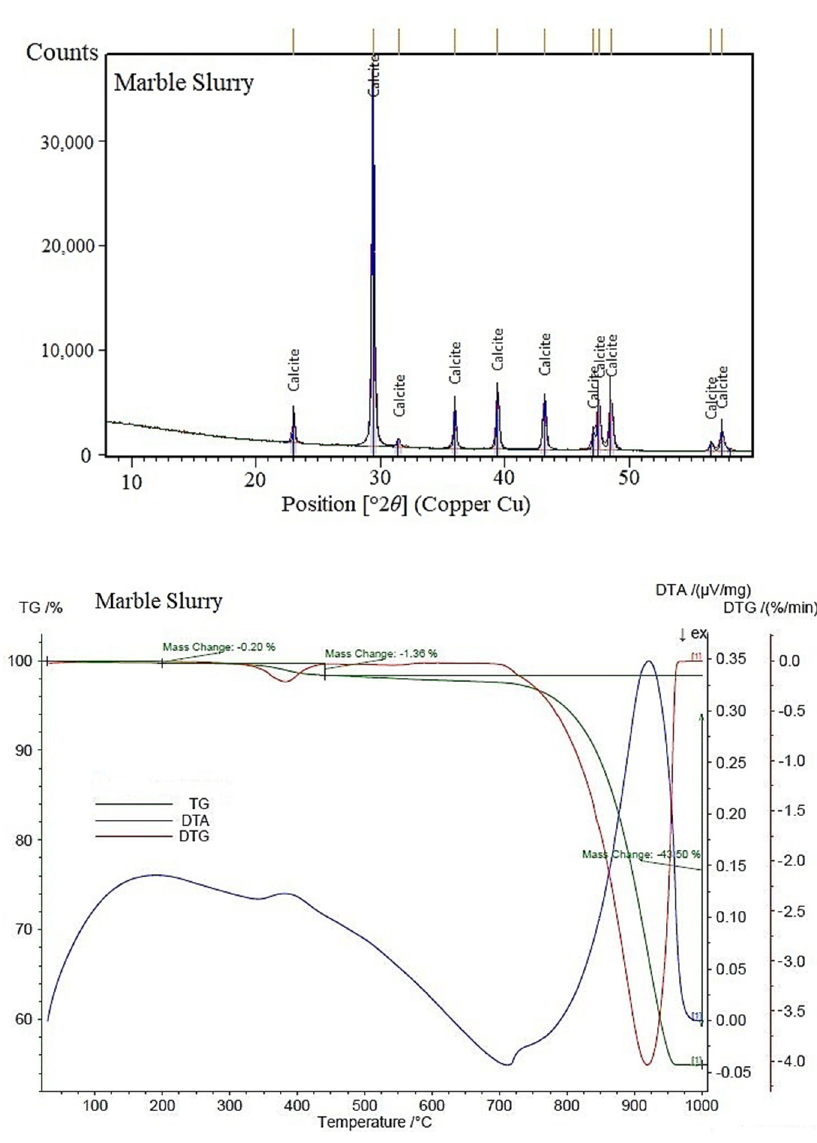
Figure 4. Characterization of marble slurry: XRD pattern ( above ); STA results ( below ).